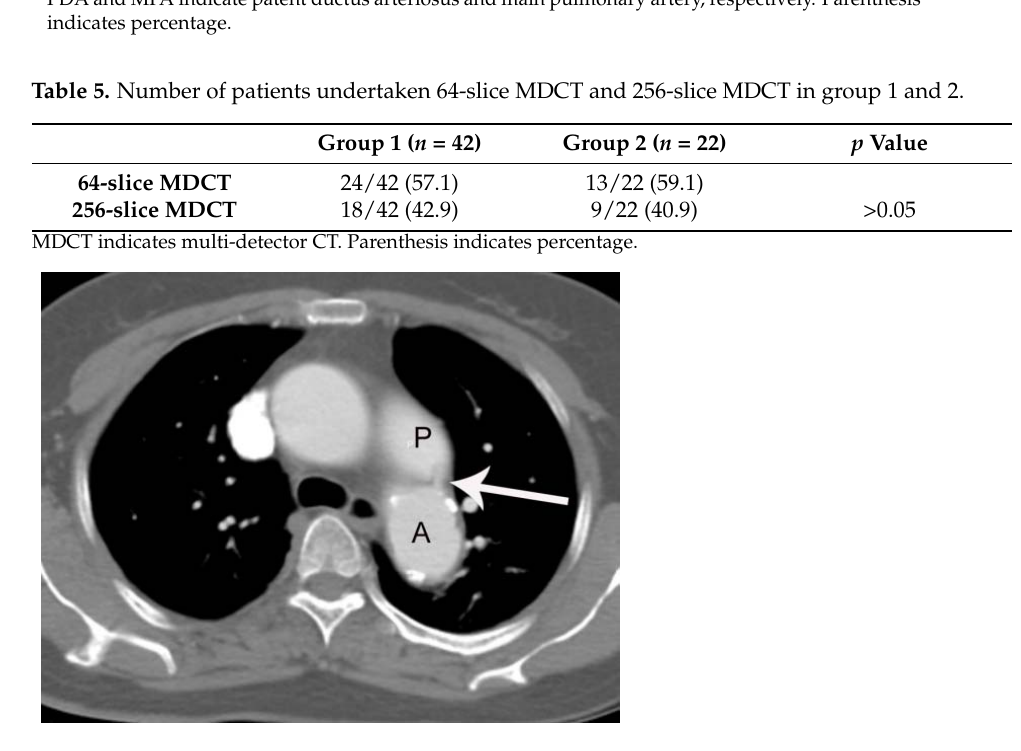
MDCT indicates multi ‐ detector CT. Parenthesis indicates percentage.